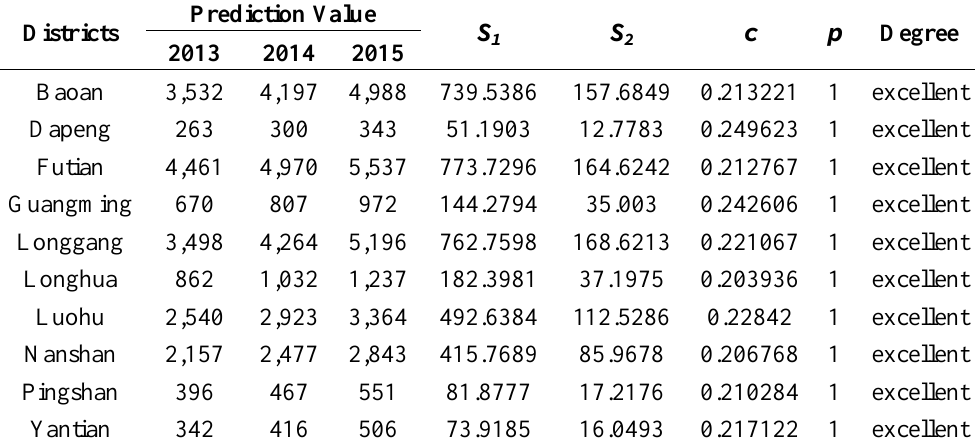
Table 2. Prediction of IHD hospital admissions based on GM